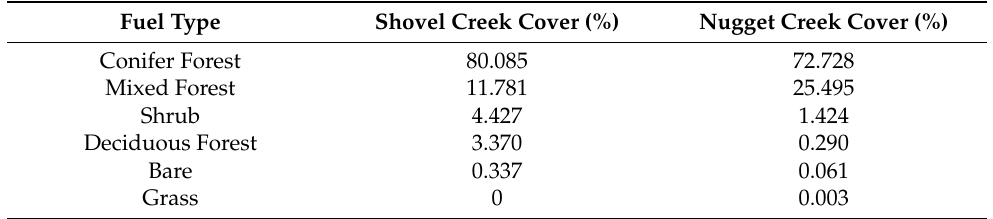
Table 4. Pre-fire vegetation cover by fuel type in the Shovel Creek and Nugget Creek burn scars as per the AVWC